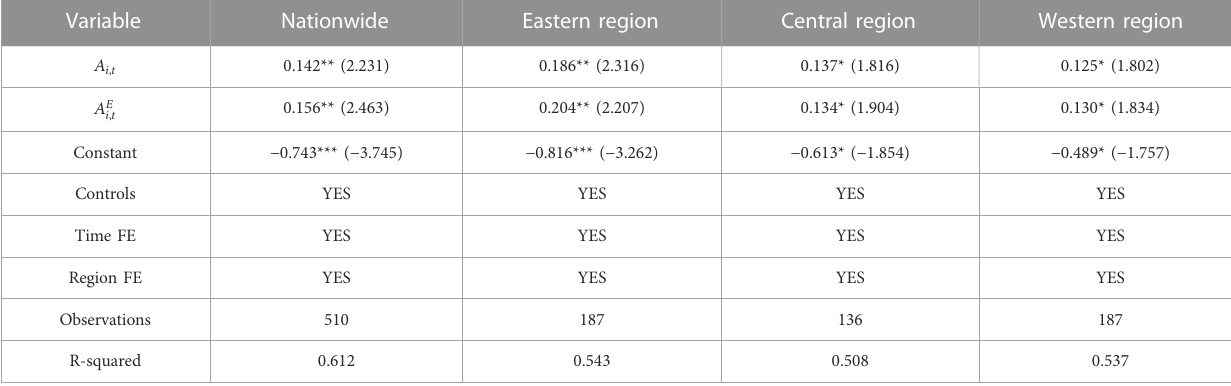
TABLE 7 Regression results of the impact of technological progress on carbon productivity in China ’ s service industry after replacement of explained variable.